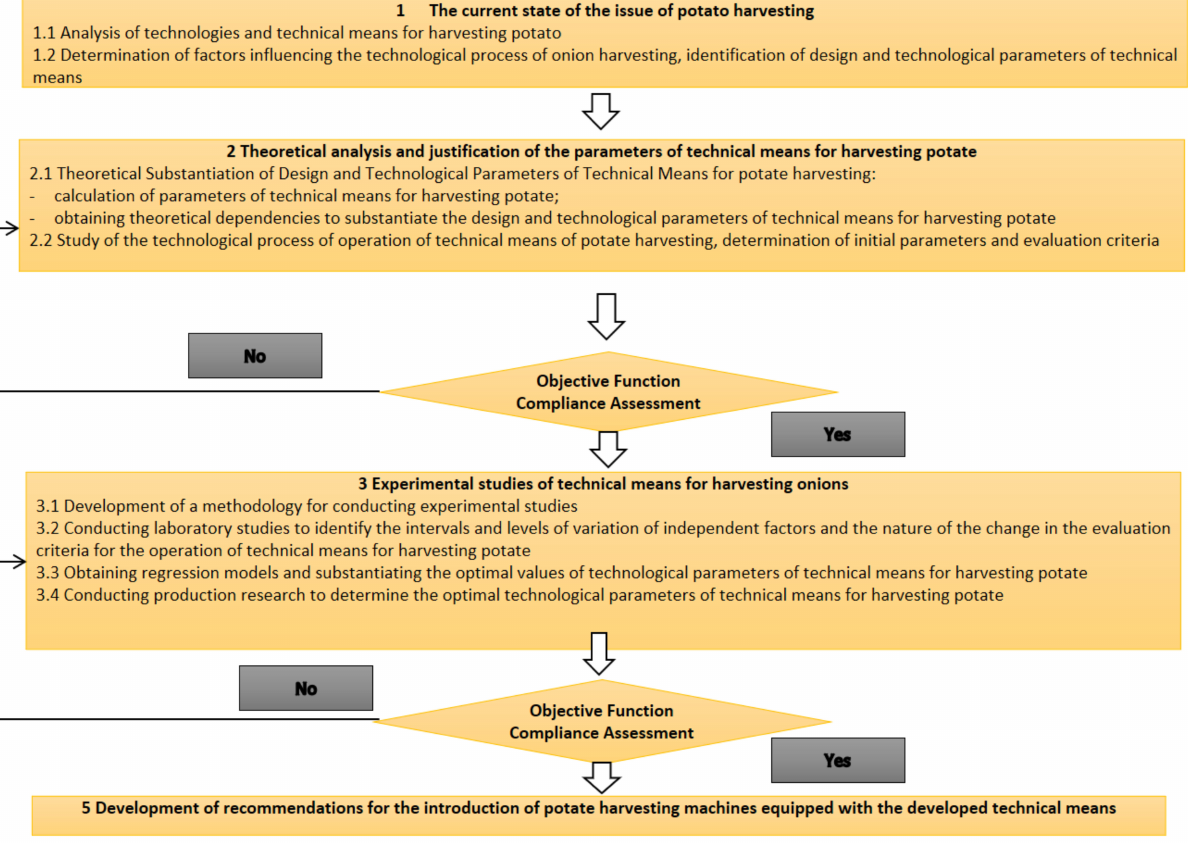
Figure 7. Structural scheme of research.